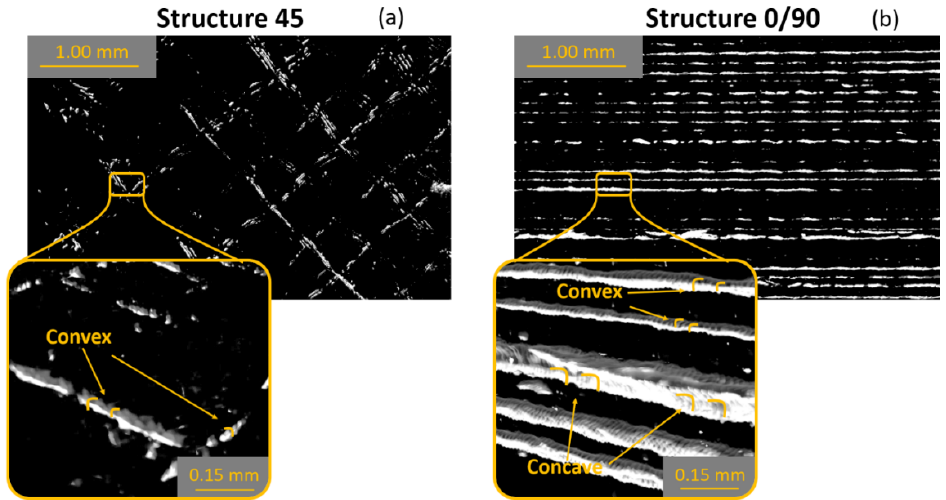
Figure 5. Micro-CT images of the voids (depicted in white) within the nylon matrix (depicted in black) for ( a ) Structure 45 and ( b ) Structure 0/90.